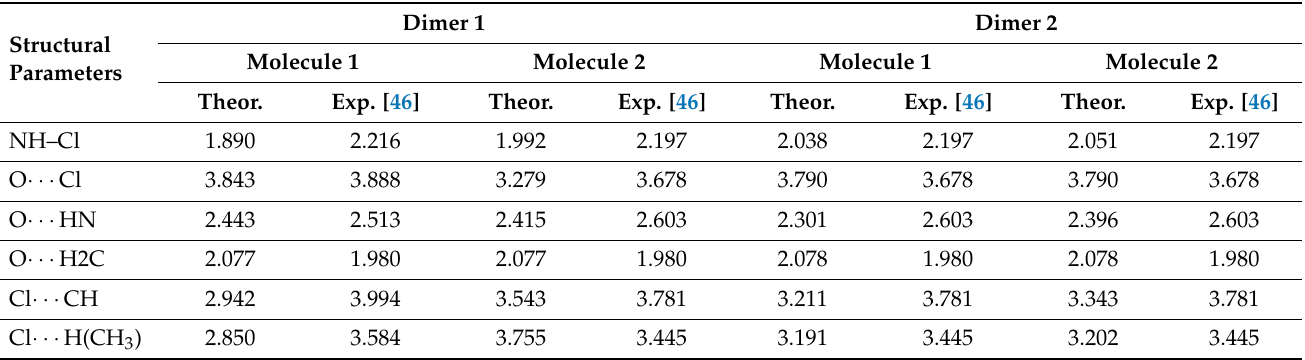
Table 1. Selected intramolecular distances (Å) for the dimer 1 and dimer 2 of methylone hydrochloride calculated at the B3LYP/6-31G(d,p) theory level.